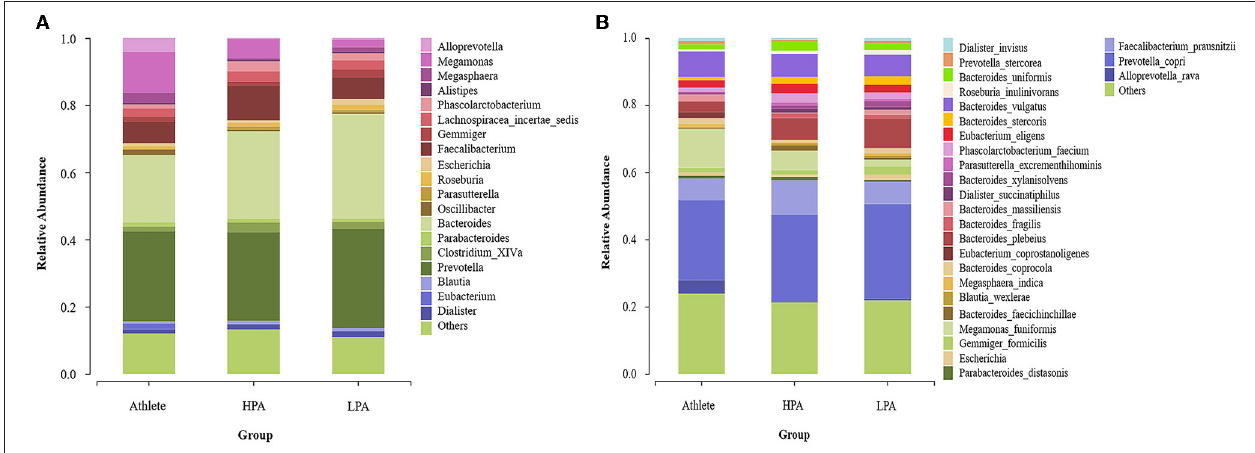
FIGURE 3 | Differences of gut microbiota relative abundance at the genus and species level among three groups. Relative abundance represents the proportion of each species in each group; (A) genus level; (B) species level; Athlete, Athlete group; HPA,High physical activity group; LPA, Low physical activity